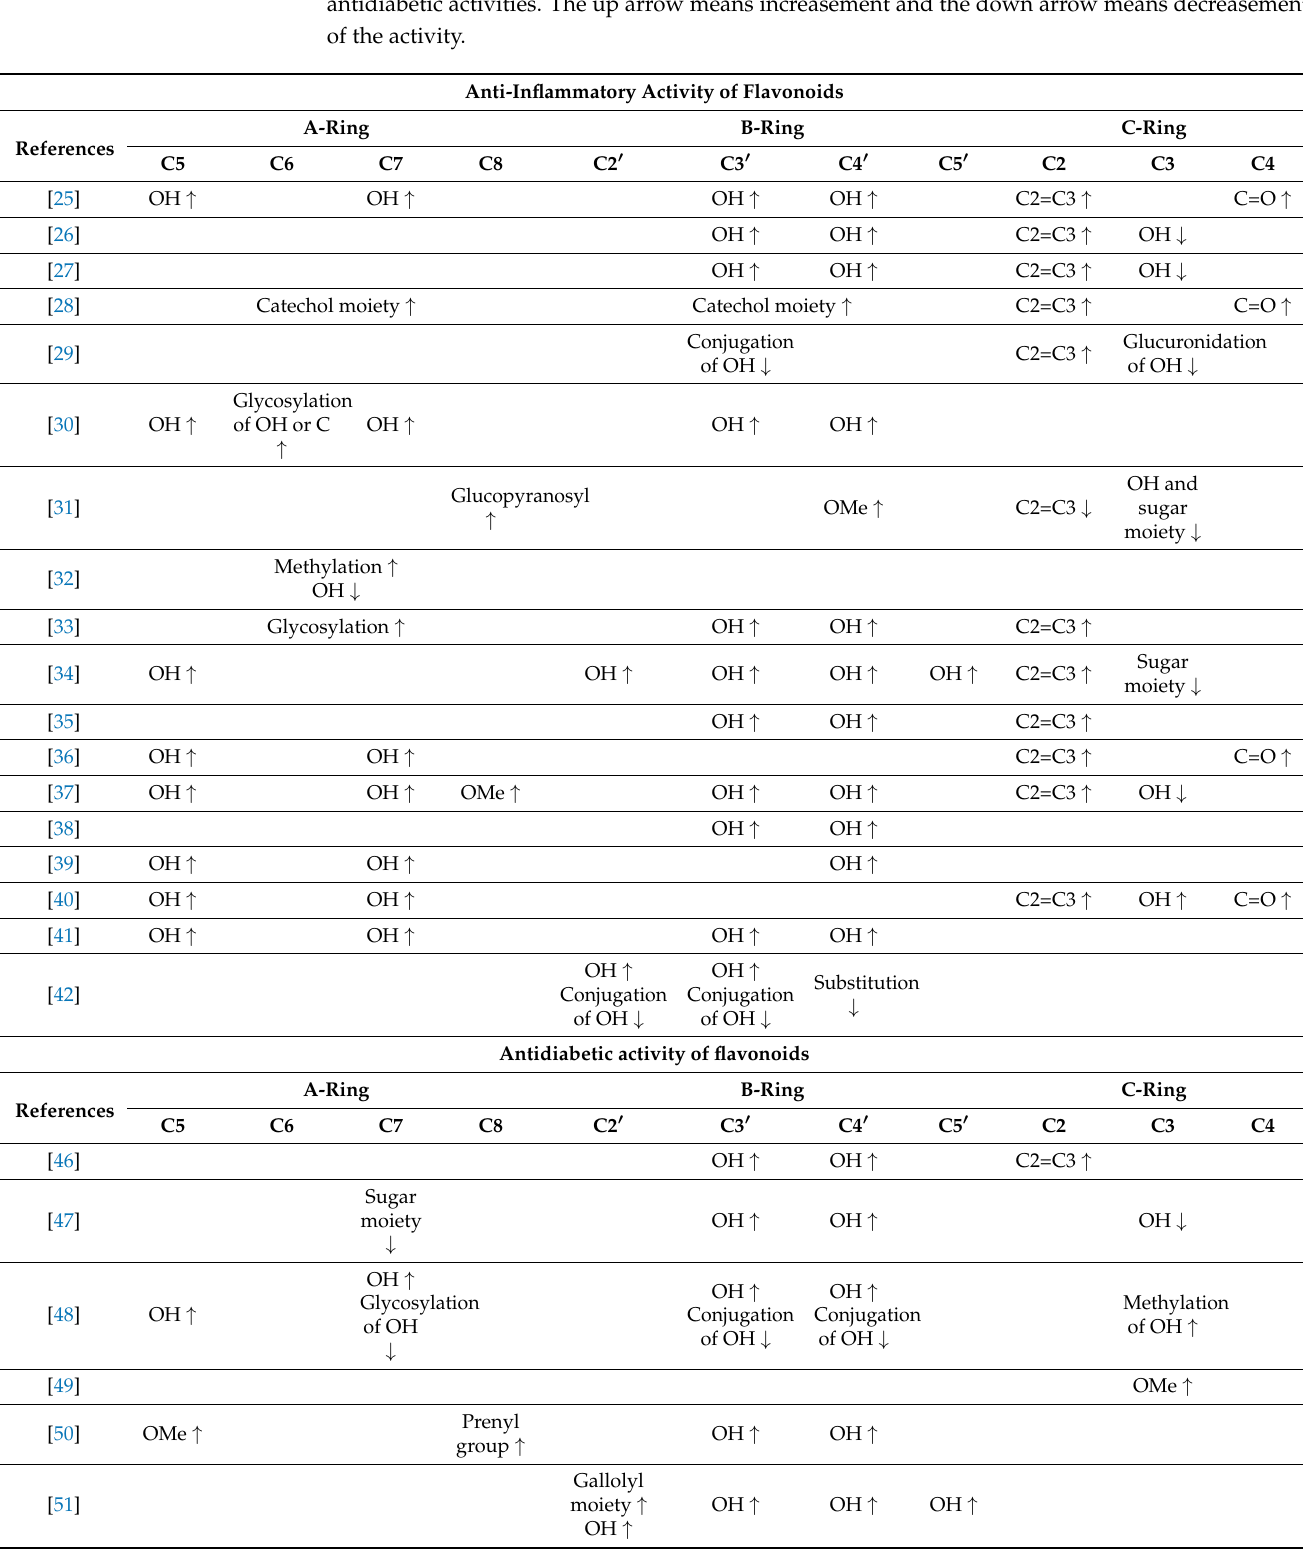
Table 2. Important structural characteristics of different classes of flavonoids as anti-inflammatory and antidiabetic activities. The up arrow means increasement and the down arrow means decreasement of the